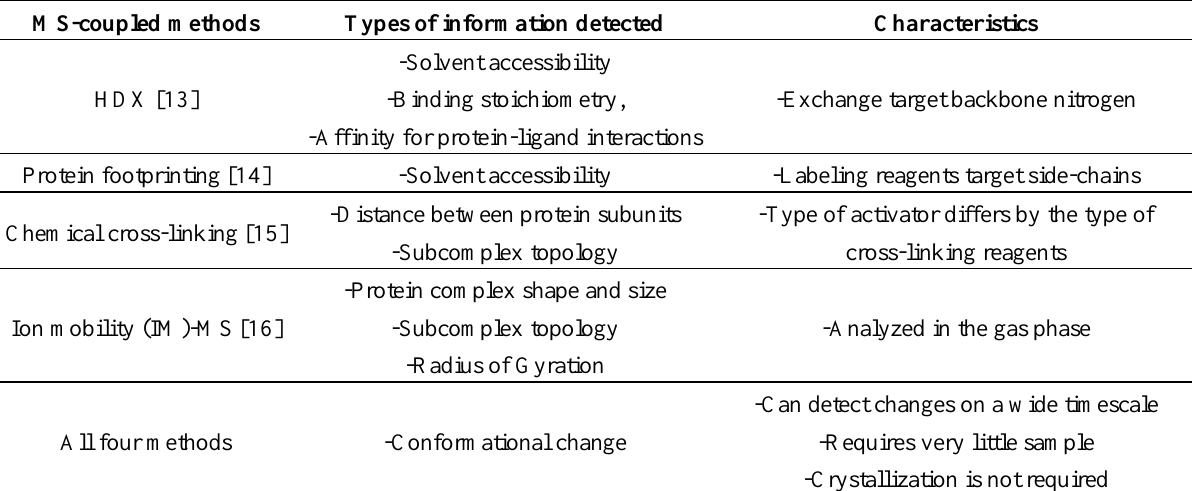
Table 1. Types and characteristics of mass spectrometry-coupled